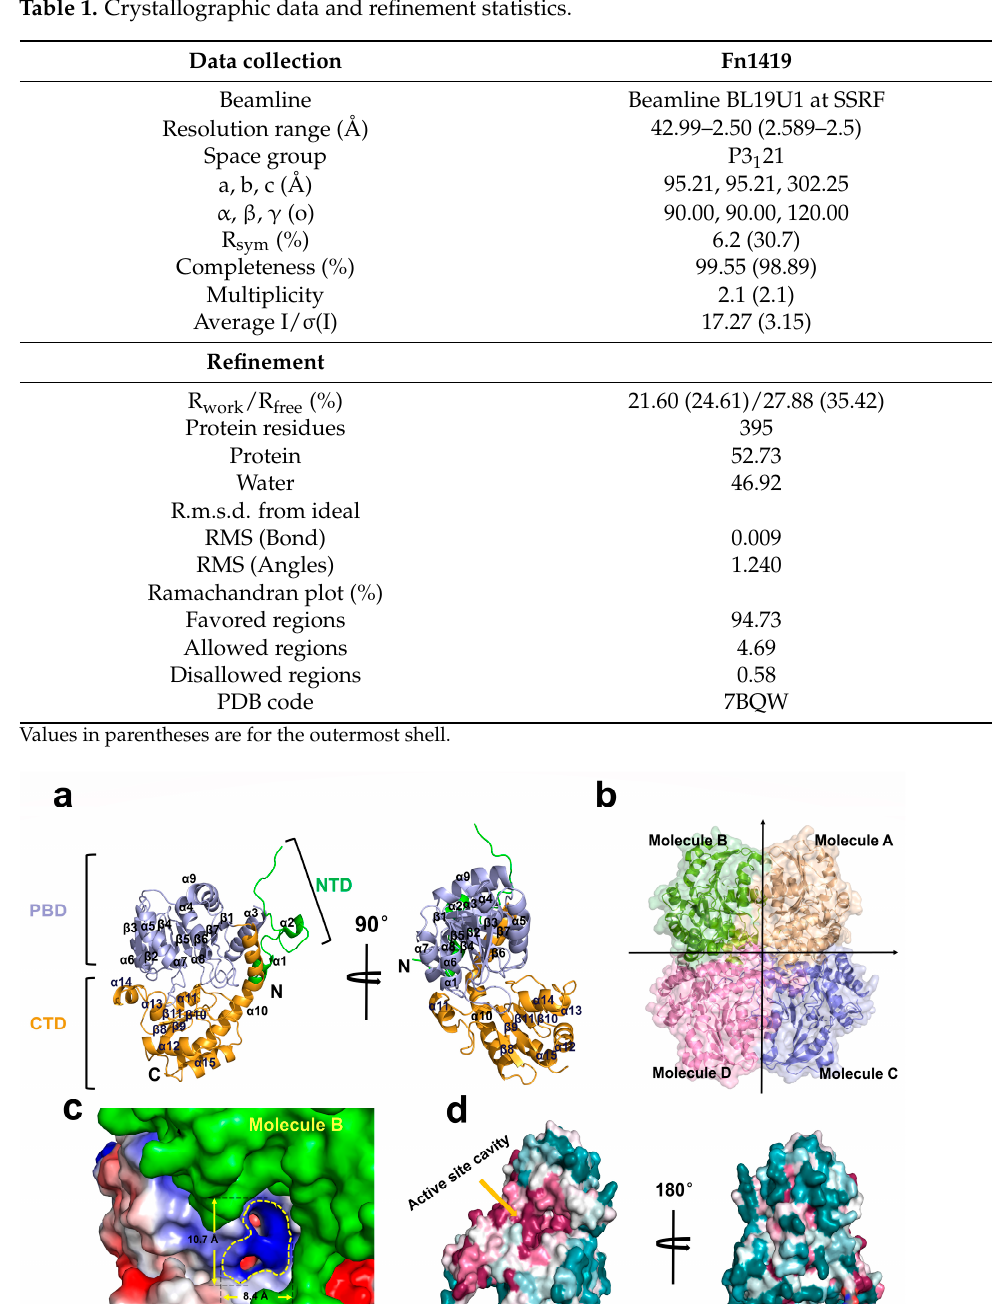
Table 1. Crystallographic data and refinement statistics.